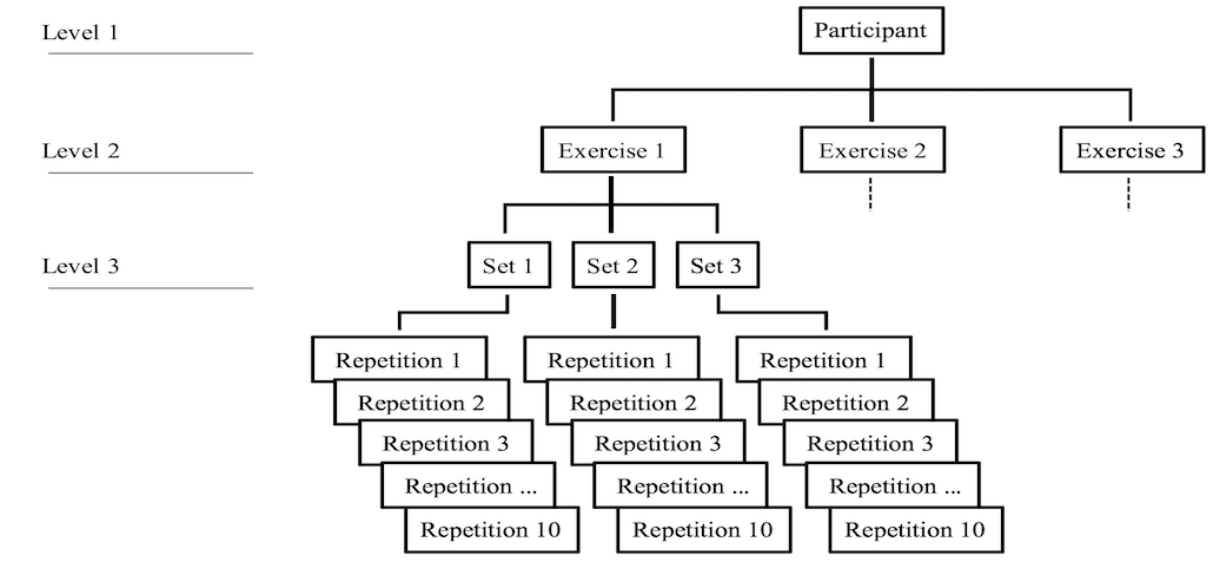
Figure 4. Hierarchical model.